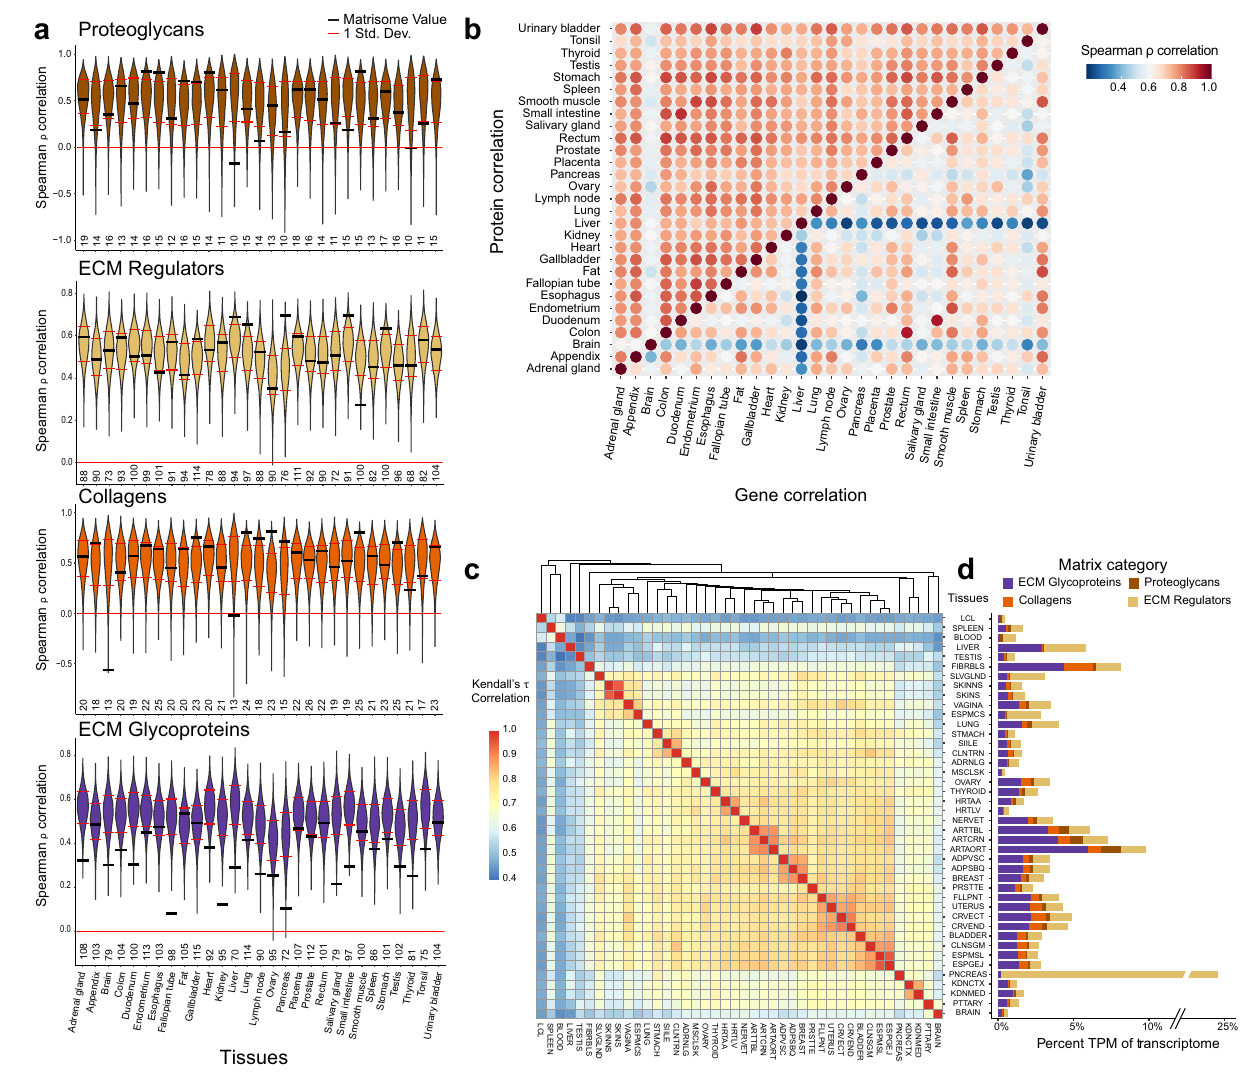
Figure 1. A transcriptomic and proteomic overview of the matrisome. ( a ) Four violin plots of 10,000 permutations of gene-protein Spearman’s correlations. The N of proteins per tissue is determined by how many protein/gene pairs were detected for each of the 4 matrisome classes. The black bars are the Spearman’s ρ correlation for the matrisome protein-gene pairs. ( b ) A heatmap correlation of matrisome proteins (top left) and gene mRNAs (bottom right) between tissues showing stronger correlations among proteins. ( c ) A Kendall’s τ correlation heatmap of each tissues’ median expression of matrisome genes. Multiple brain region datasets are collapsed into one tissue by using the median expression of each gene across these samples. GTEx abbreviations are used. ( d ) The median percent transcriptome of matrisome categories for each tissue. The colored bars each represent a different matrisome